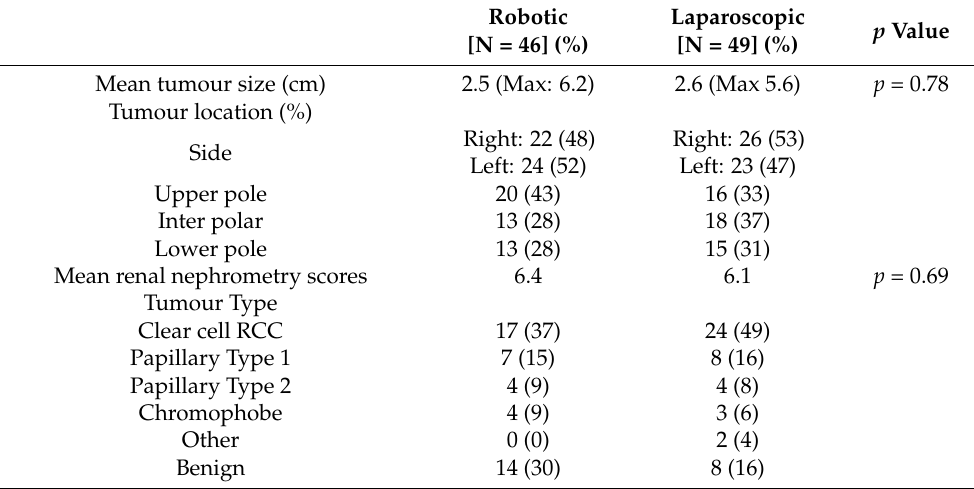
Table 2. Tumour characteristics: Tumour size and location based on pre-operative radiological imag- ing with either CT imaging or magnetic resonance imaging. Histological diagnosis from pathology specimens of lesion